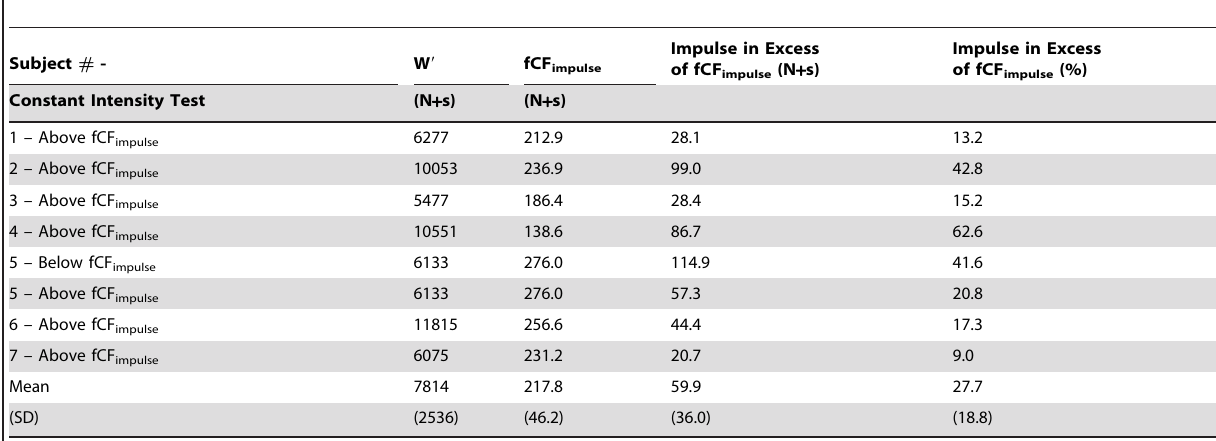
Table 3. Individual W 9 estimated from maximal effort test, and average contraction impulse above fCF impulse in the constant intensity exercise tests where subjects exercised above fCF impulse